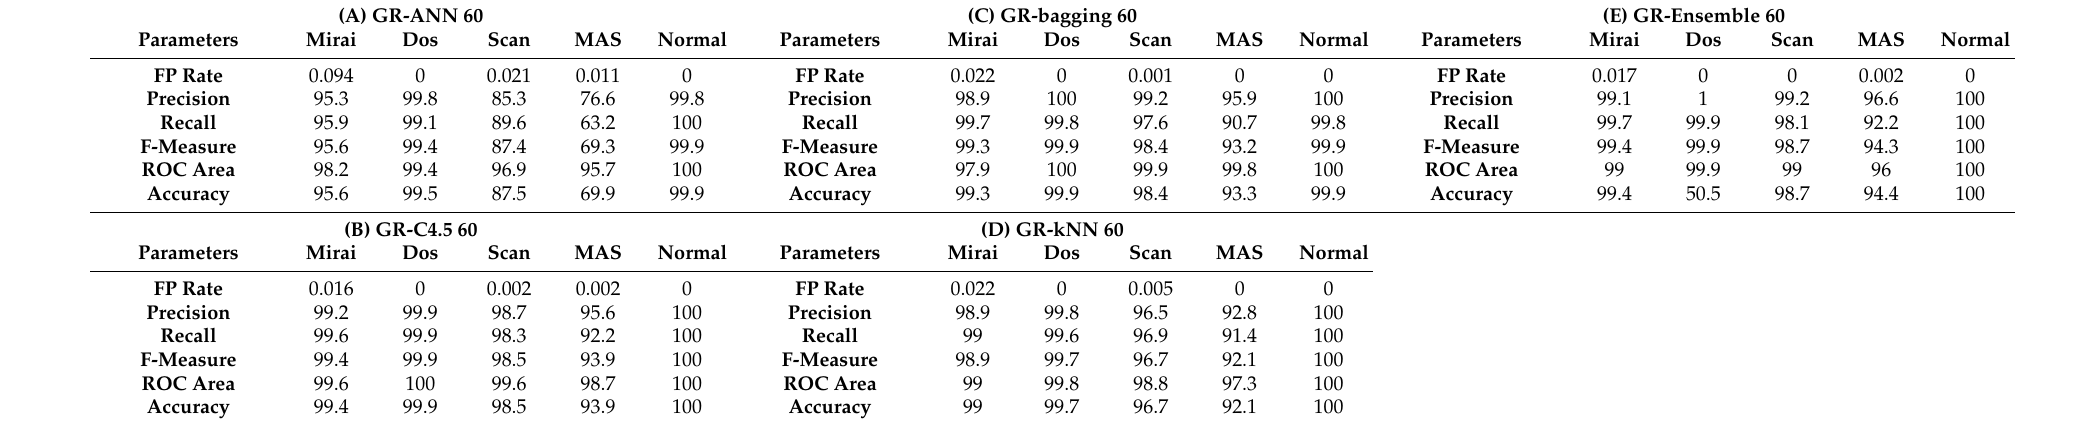
Table 10. Summary of calculated statistical parameters for test IoTID20 dataset using GR with top-ranked 60